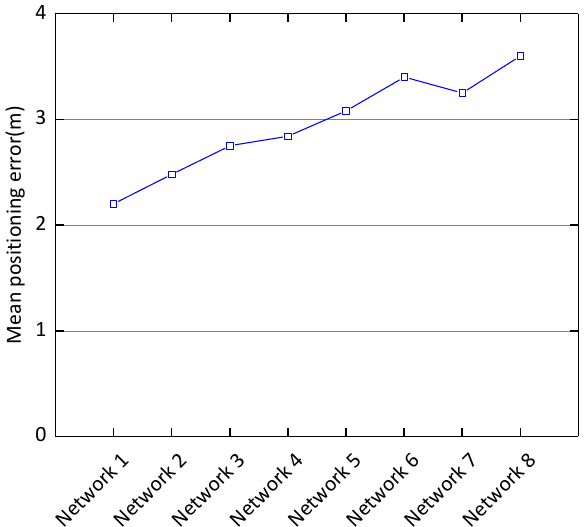
Figure 4. Mean positioning error of different network structures.